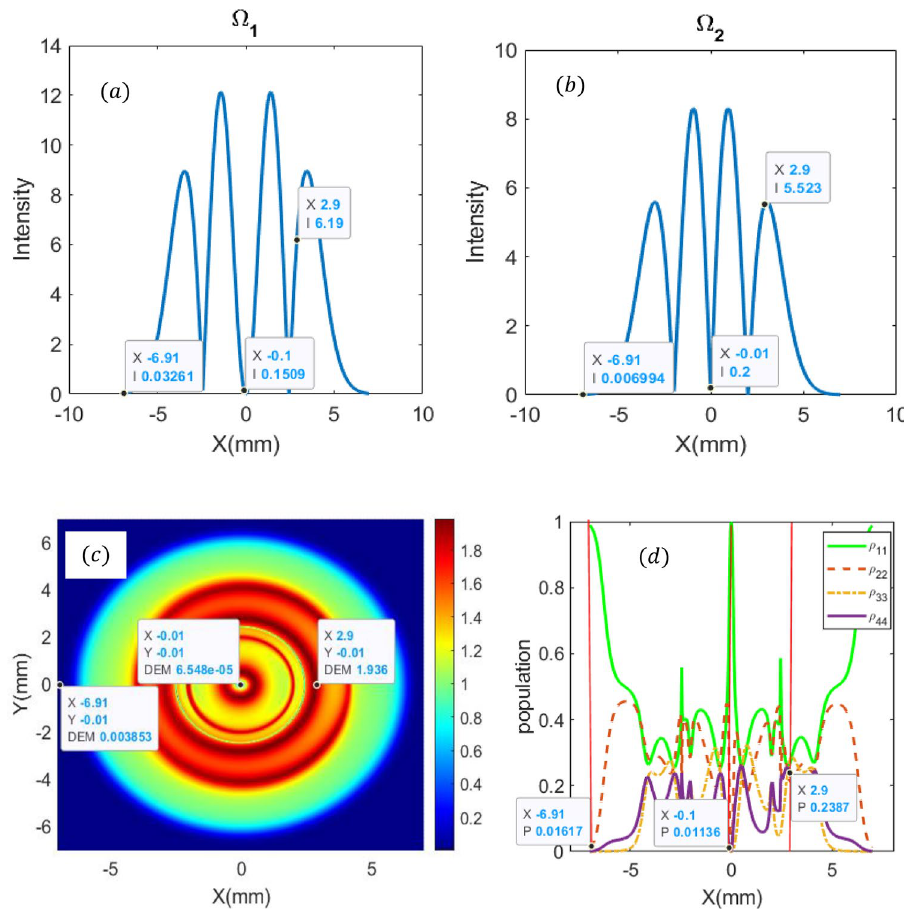
Figure 3. Intensity profiles of applied LG fields (cid:31) 1 ( a ) and (cid:31) 2 ( b ). DEM density plots as a function of 2 γ , and T B 7 γ , x–y ( c ), and population distribution as a function of x (y = 0) ( d ). Parameters are T A = = (cid:31) 1 (cid:31) 2 1, (cid:31) 532 10 − 9 m, I 0 10 γ , δ p 1, w 0 2 mm , C l 0 and ω 43 0.6 γ . The parameter p = = × = = = = = = = y represents the population distribution in presented